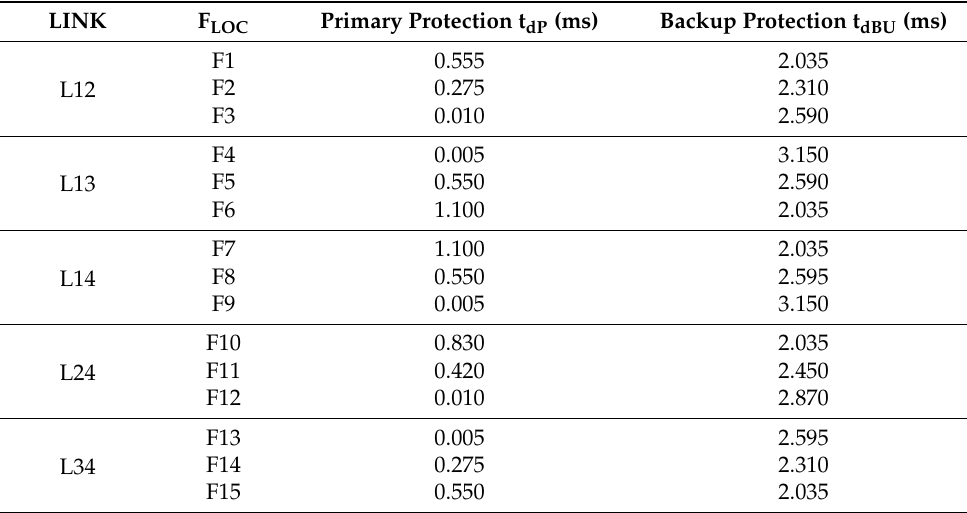
Table 2. Fault detection time in milliseconds for the proposed protection system against different 0 Ω PtP fault